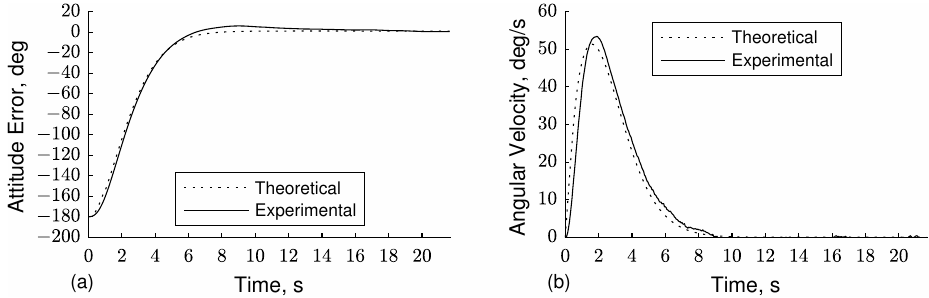
Figure 10. ( a ) Attitude error and ( b ) angular velocity of the platform for 180 deg maneuver.